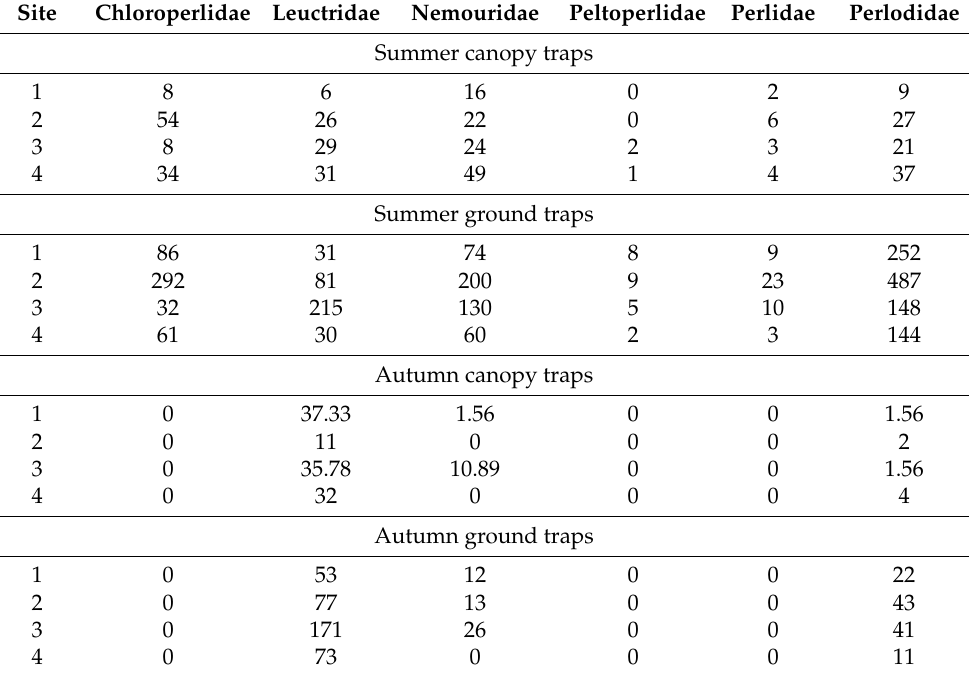
Table 3. Abundances of the six plecopteran families among trap types and sampling